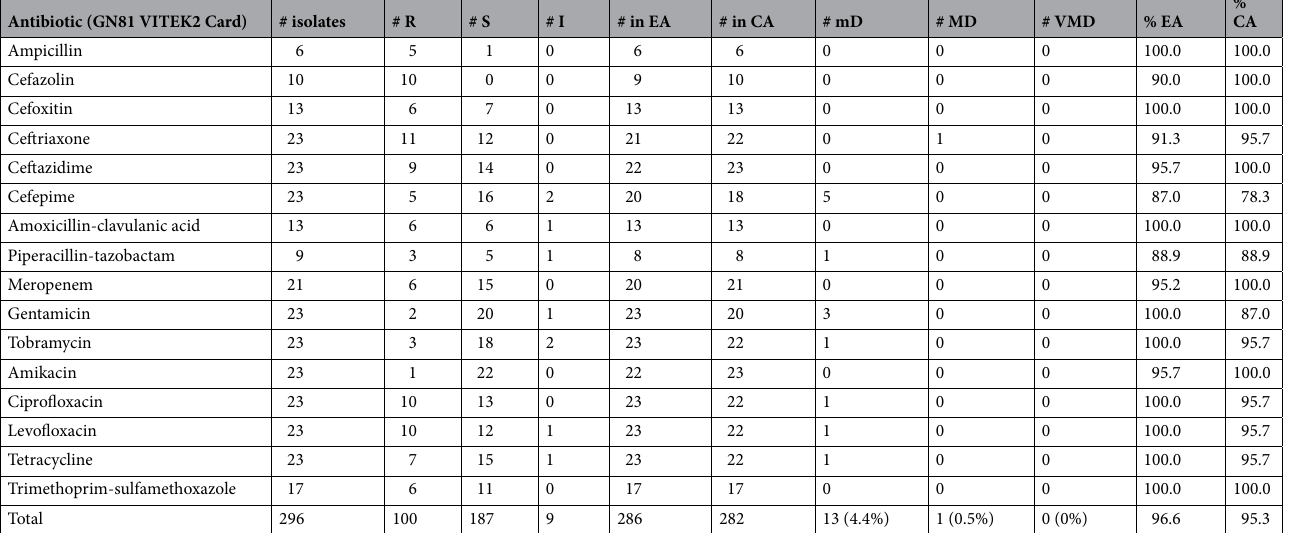
Table 1. VITEK2 GN81 antimicrobial susceptibility results for the eMcF compared to the traditional 0.5 McF. Results for 23 Gram-negative isolates comprising seven species, E. coli (6), E. cloacae (2), K. pneumoniae (3),